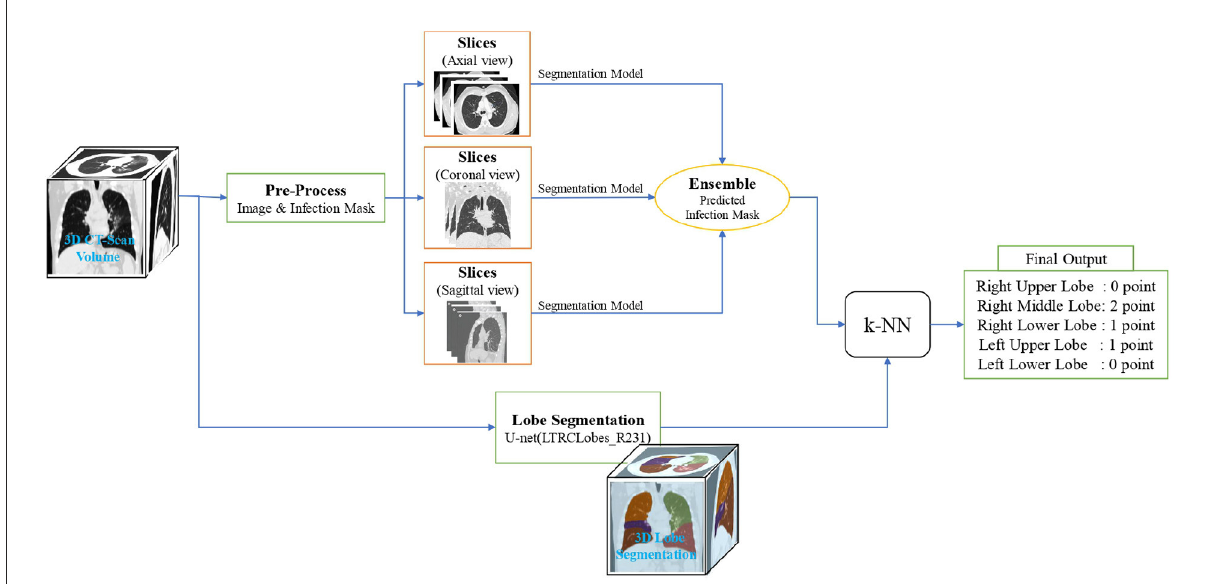
FIGURE2 Overview of the lung lobes infection severity prediction framework. An input image is simultaneously given the lobe segmentation and infection segmentation models. Then, by combining the output of these two models, the infection percentage of each lobe is predicted and given as the input of the k-NN model to predict the severity of infection in terms of the 6 classes of infection severity for all the 5